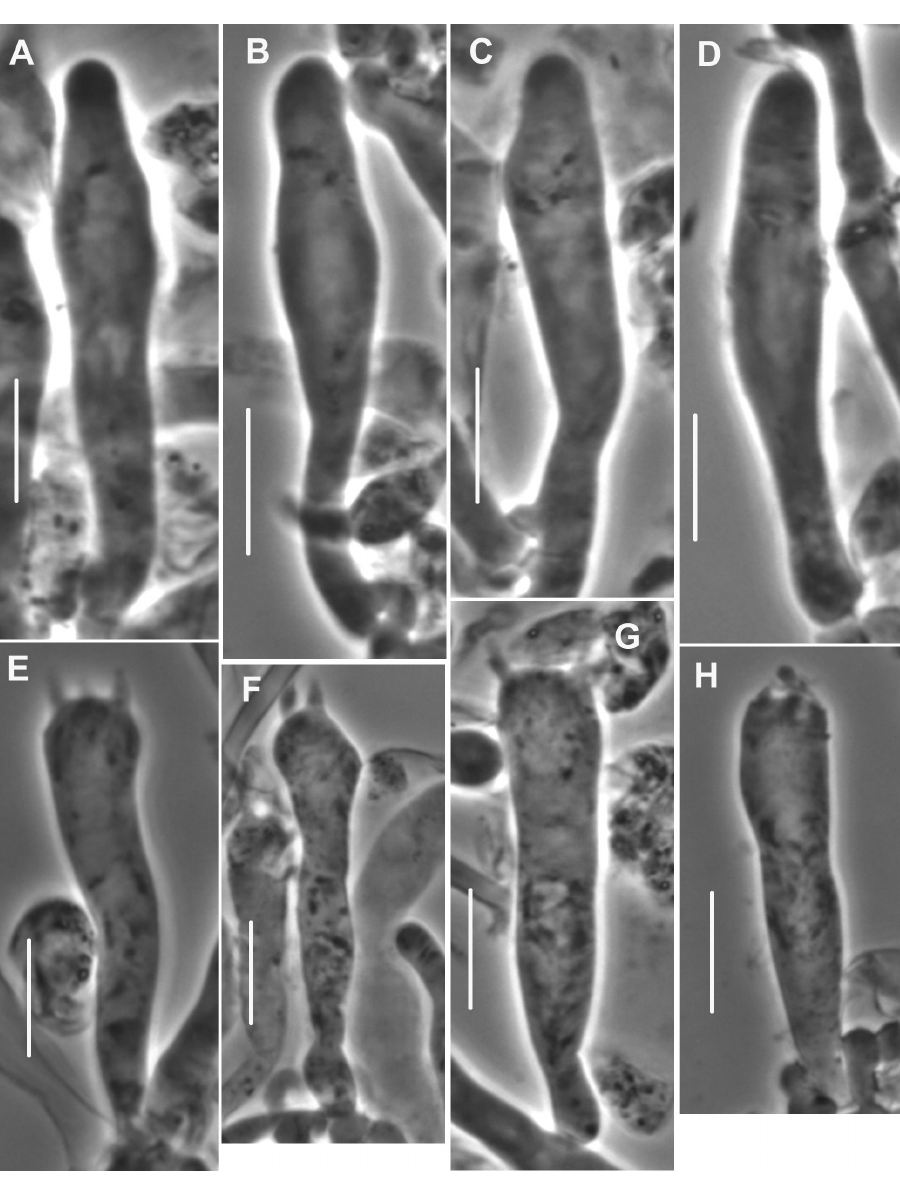
Figure 61. Mycetinis prasiosmus . Hymenial structures. A–D Pleurocystidia E–H Basidia. Standard bars = 10 µm. FES 1155